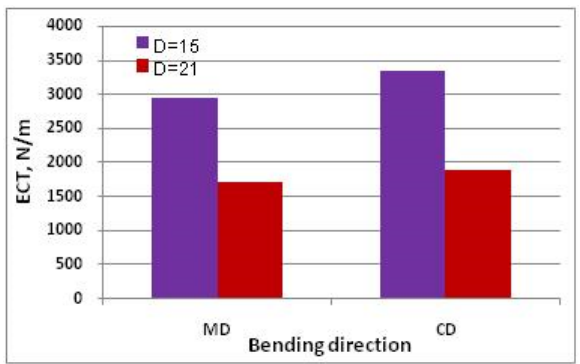
Figure 11. ECT of paperboard with thickness H = 20 and different mesh sizes, made of paper T200/F140/T200.